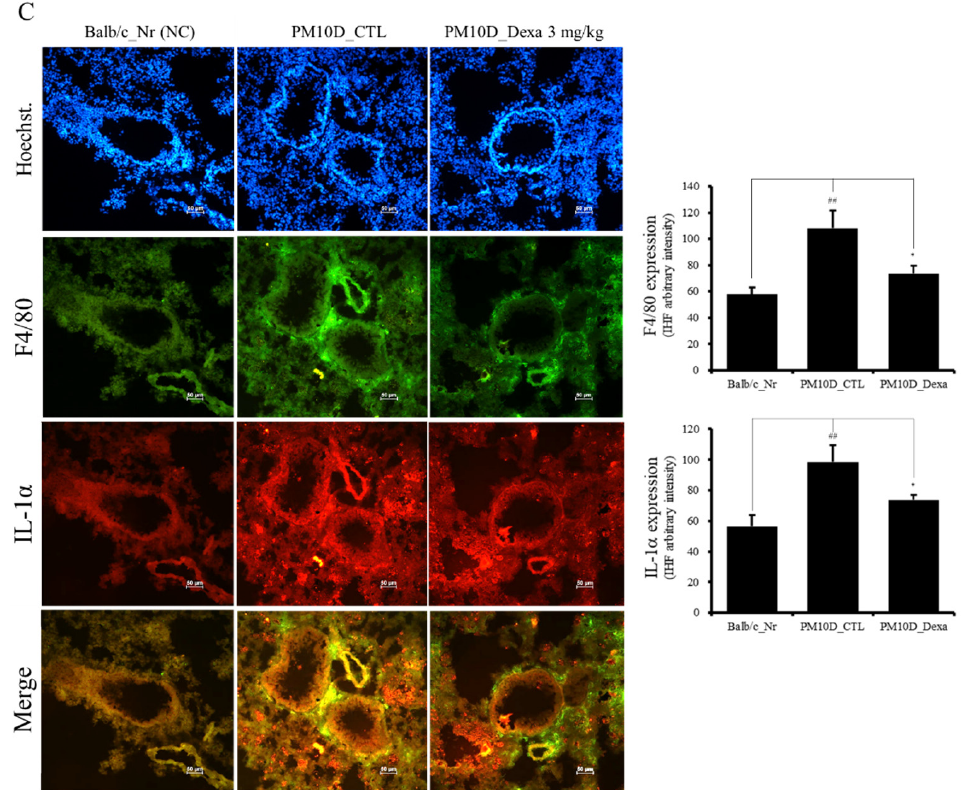
Figure 7. Effects of PM10D on inflammatory responses in the lung. ( A ) Caspase-1 expression, ( B ) NLR family pyrin domain containing 3 (NLRP3) and caspase-3 expression, and ( C ) immunofluorescence staining for F4/80 and IL-1 α in the lung. BALB/c normal control group; CTL: PM10D-induced control group; Dexa: 3 mg/kg dexamethasone-treated PM10D-induced group. Data are expressed as means ± SEM, n = 5. ## p < 0.01 vs. NC; * p < 0.05 vs. CTL.